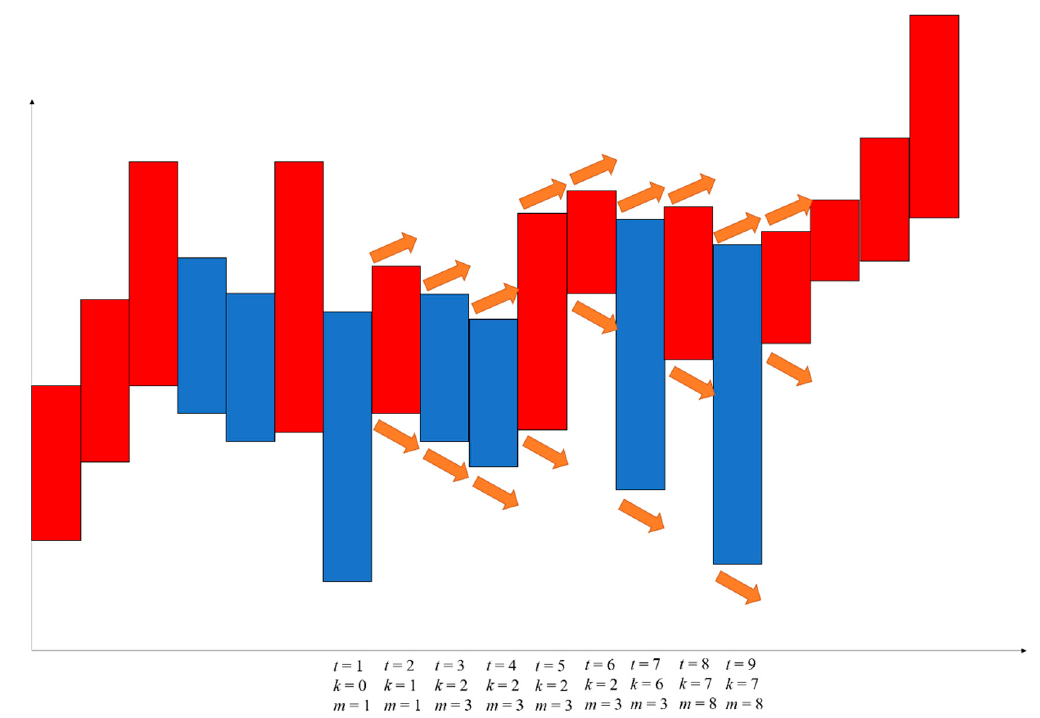
Figure 6. Practical example of an alert period (turbulence case between two ascending trends).